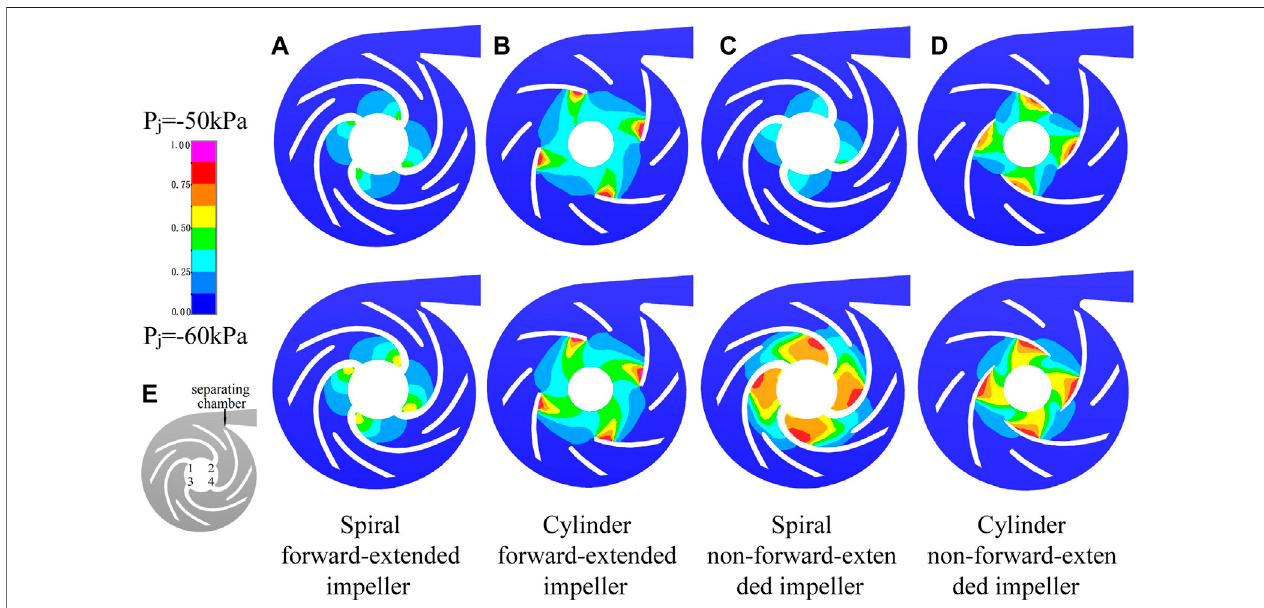
FIGURE 9 | The cavitation bubble volume distribution diagrams of the midsections of the pumps.